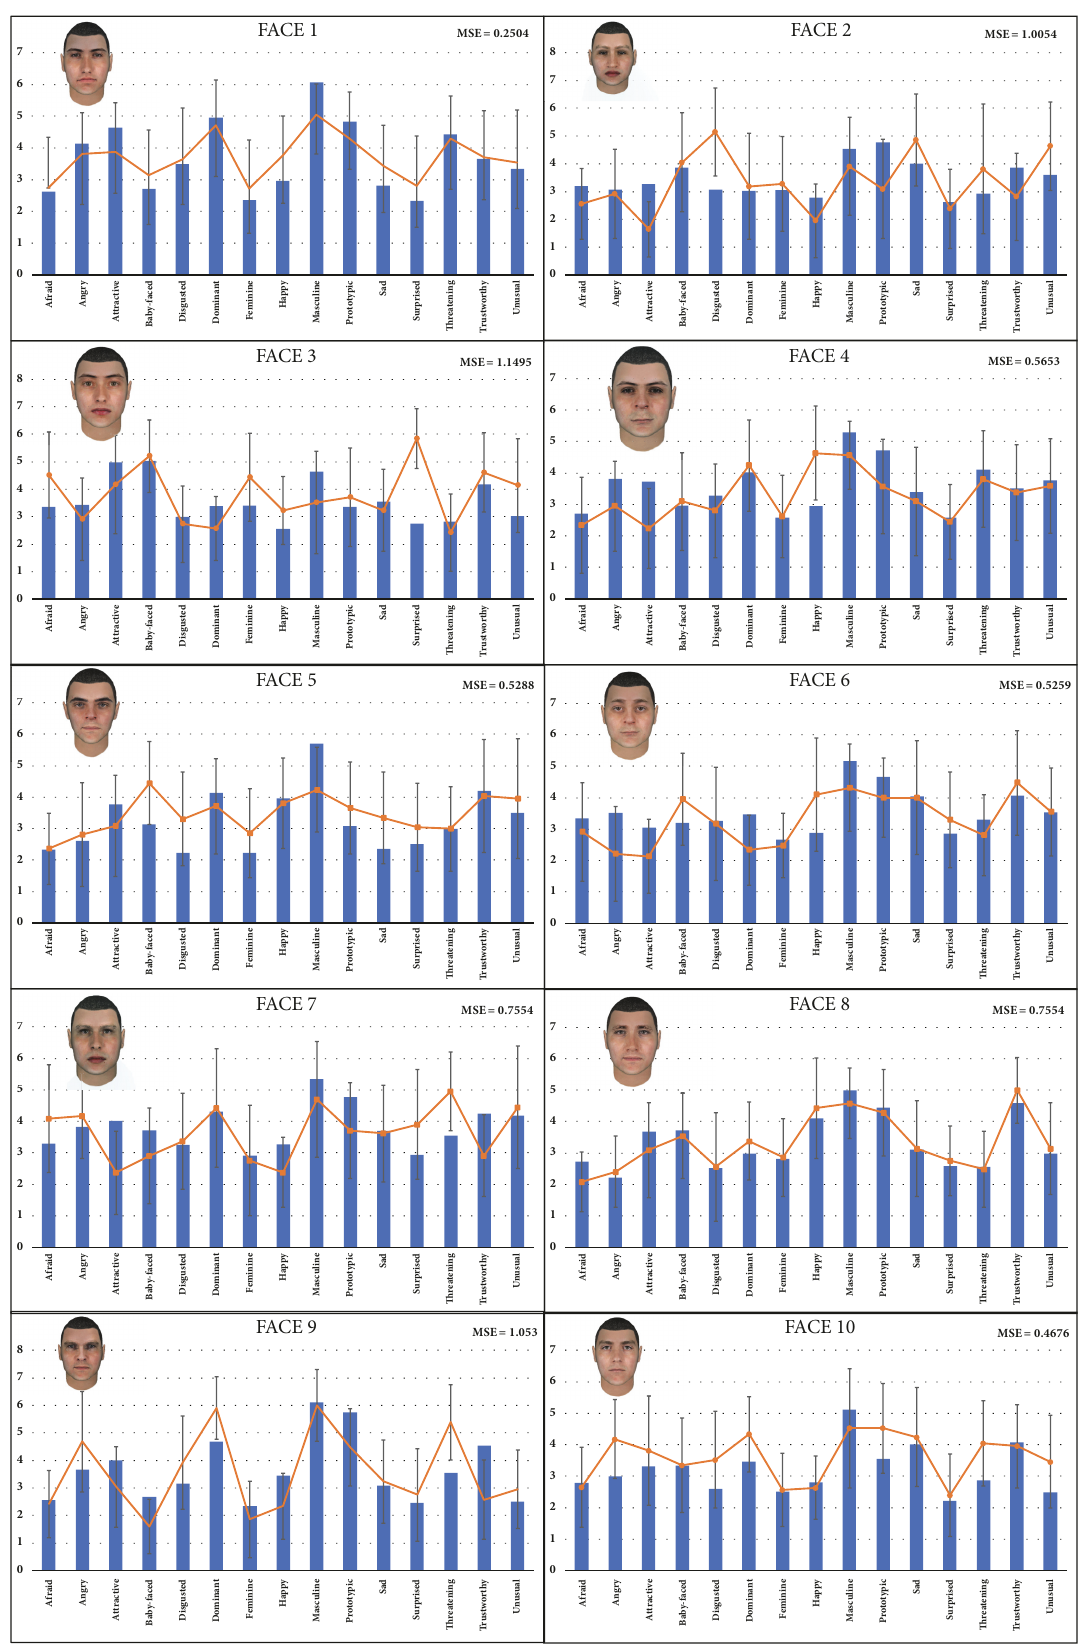
Figure 9: Scores for each face. Blue bars represent the social traits profile predicted by the models. The orange lines are the mean of the scores of human participants (whiskers represent ± 1 times the standard deviation about the